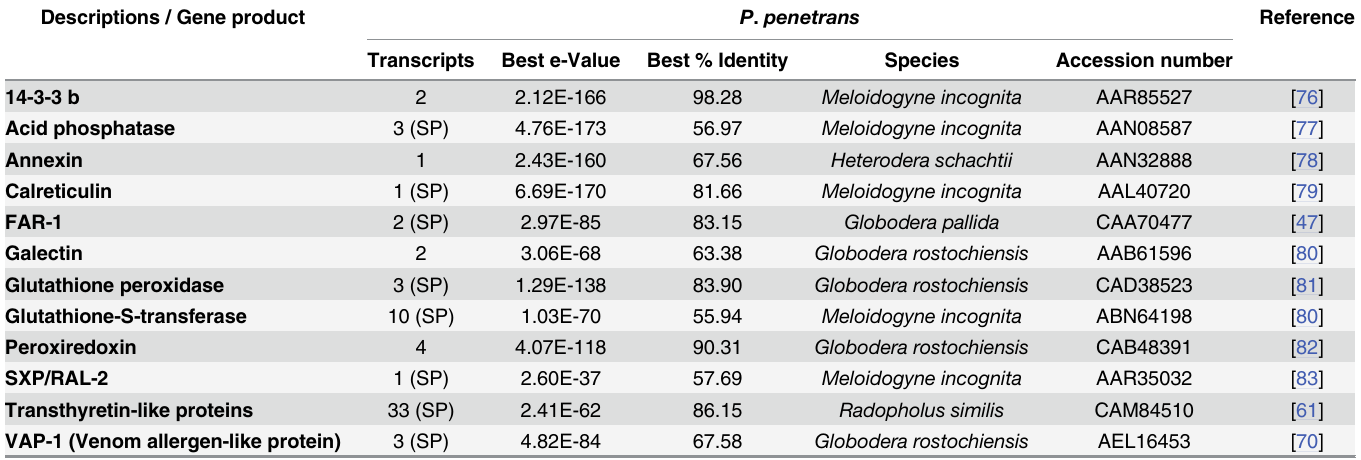
SP: Indicates that at least one sequence of each respective family of enzymes was predicted to have a putative signal